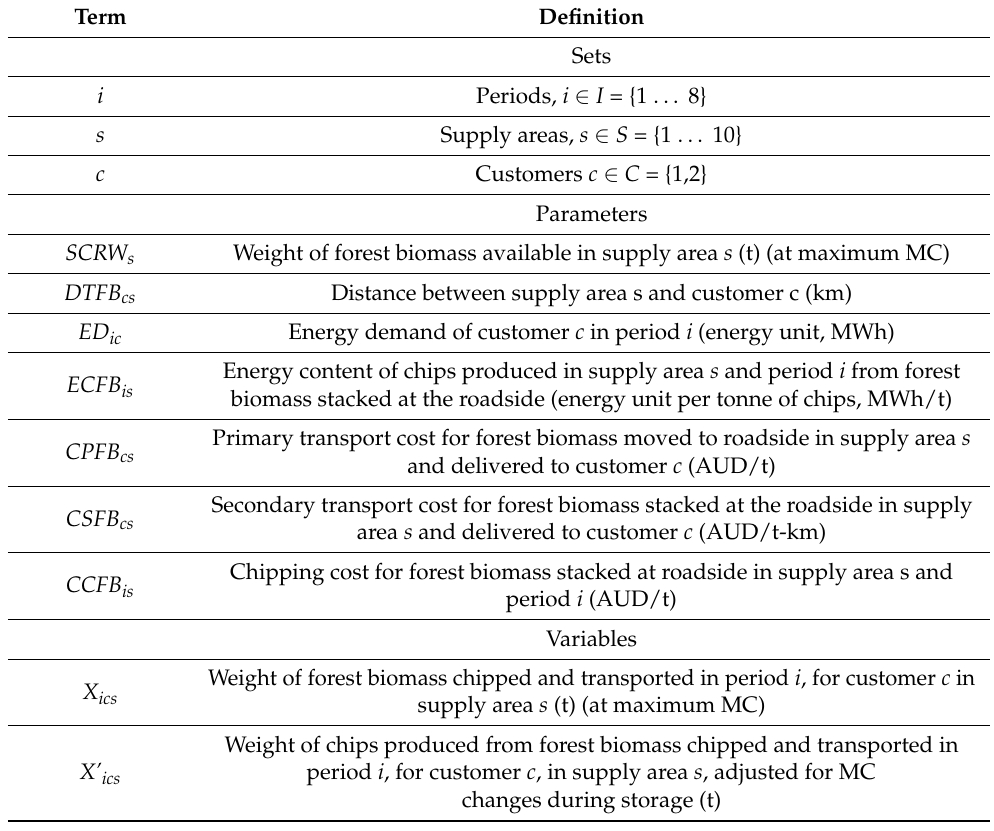
Table 2. Notation used in the